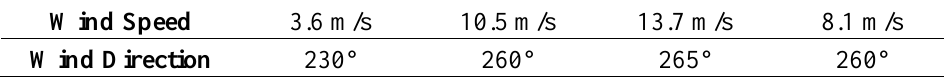
Table 4. Variation of wind directions for different mean wind